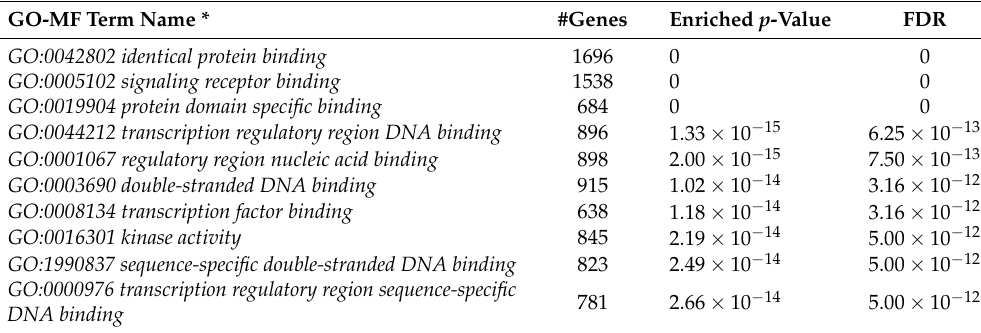
Table 8. Top significant GO-MF term enriched (FDR